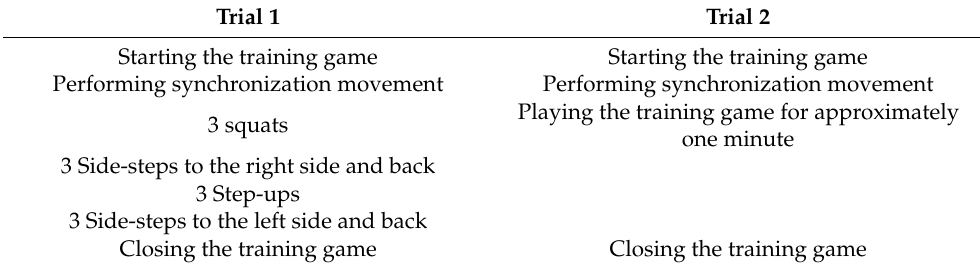
Table 2. Sequence of the measuring parts.